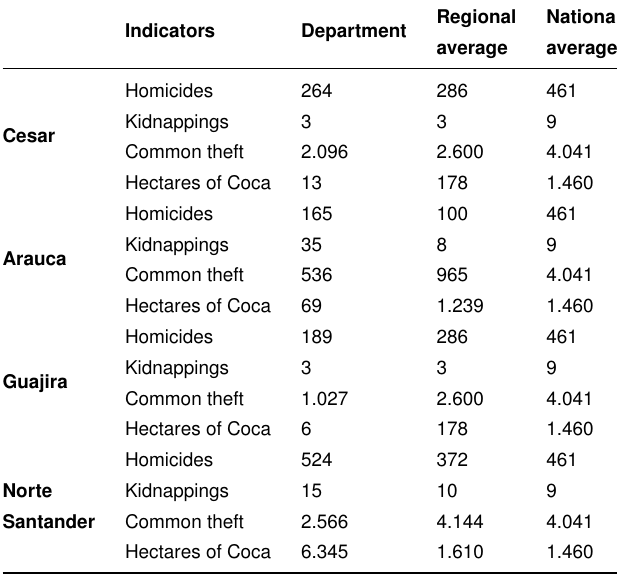
Table 2. Security indicators of the border Colombian de- partments